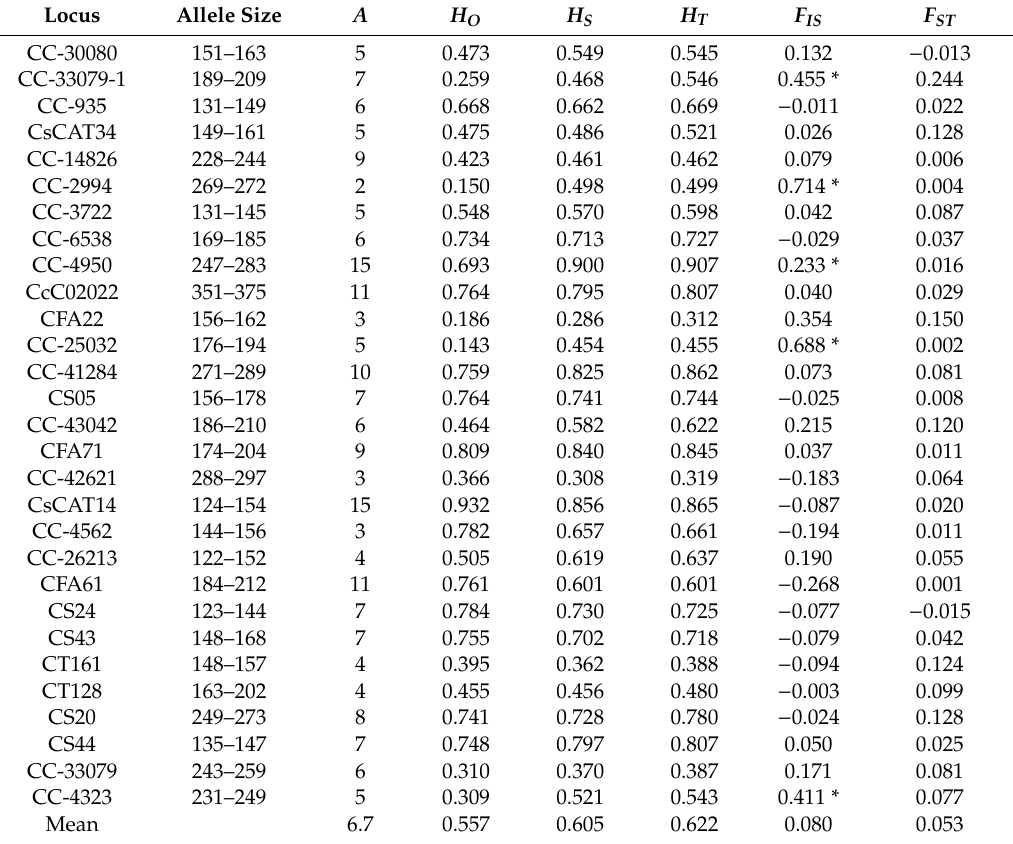
Table 3. Genetic diversity at 29 nuclear microsatellite loci in Castanopsis sclerophylla